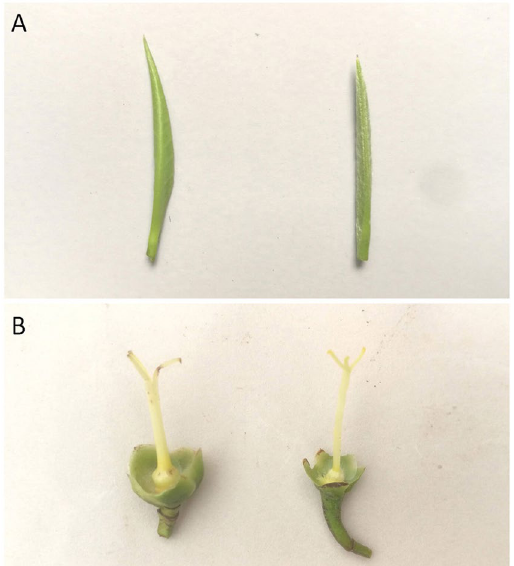
Figure 2. Morphological differences between Baiyacha (left) and cultivated tea plant (right): ( A ) pubescence density of bud; ( B ) pubescence density of